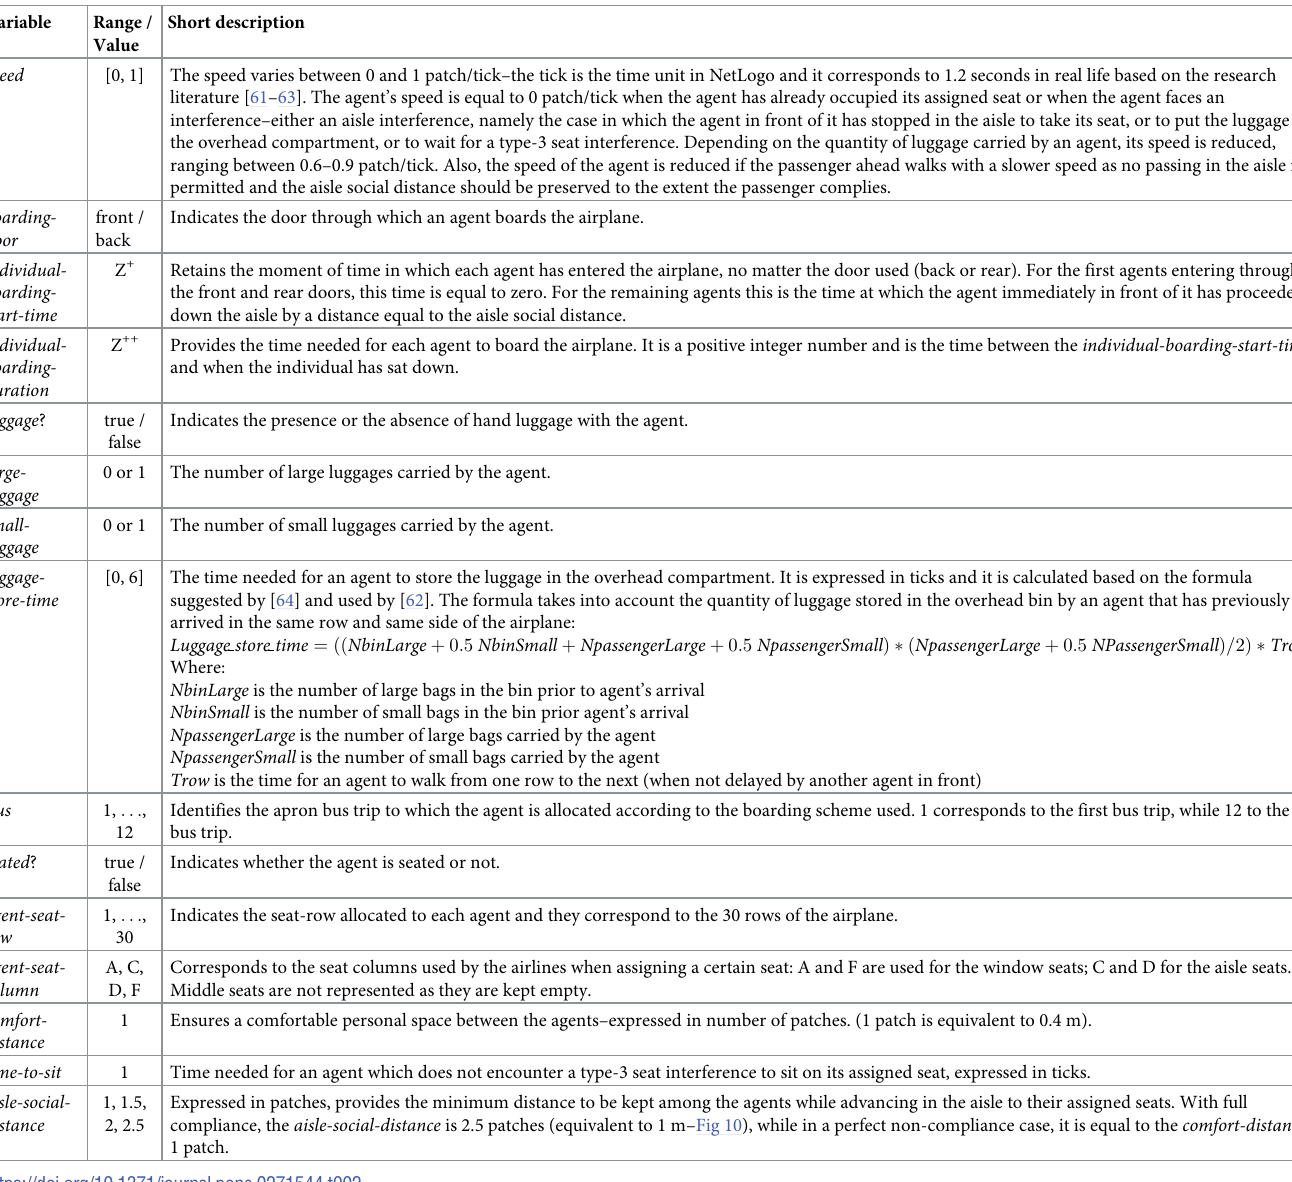
Table 2. Turtles